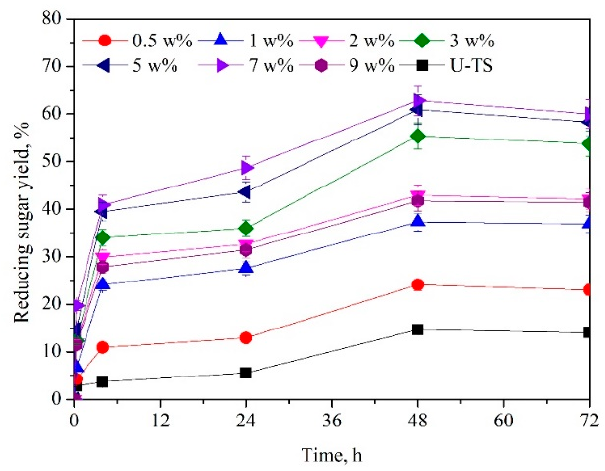
Figure 1. Effects of NaOH concentration on the enzymatic saccharification of tomato stalk (TS). [Pretreatment condition: NaOH (0.5 − 9 wt%)–ChCl:UA-TA (8 wt%), 75 ◦ C, 60 min; Enzymatic hydrolysis condition: cellulase (10.0 FPU/g TS) and xylanase (30.0 CBU/g TS), 50 o C, pH 4.8]. [U-TS represents untreated